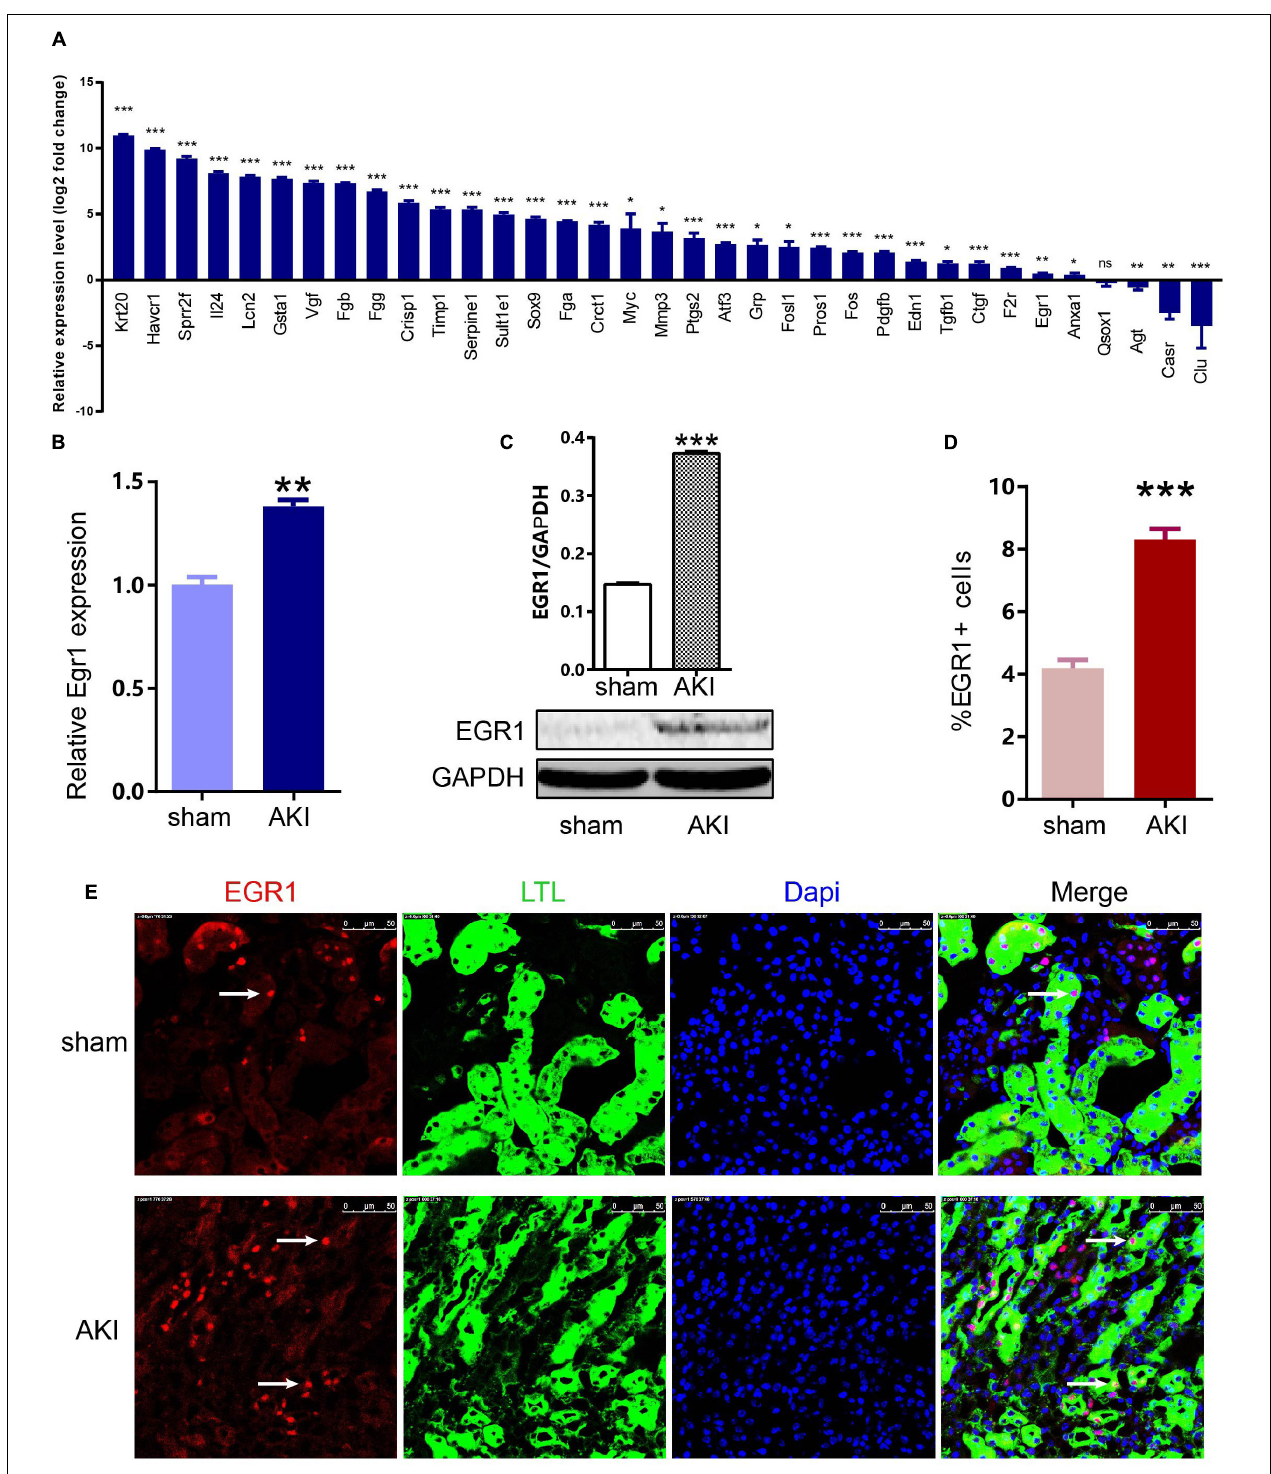
FIGURE 8 | Expression of 35 key genes and EGR1 in AKI samples and sham samples. (A) Transcriptional levels of 35 important genes including 21 hub genes and 14 other important upregulated genes in our own AKI samples. (B) Translational levels of Egr1 in AKI samples and sham samples. (C) Western blot of EGR1. (D,E) Immunofluorescence of EGR1. * p < 0.05, ** p < 0.01, *** p < 0.001.